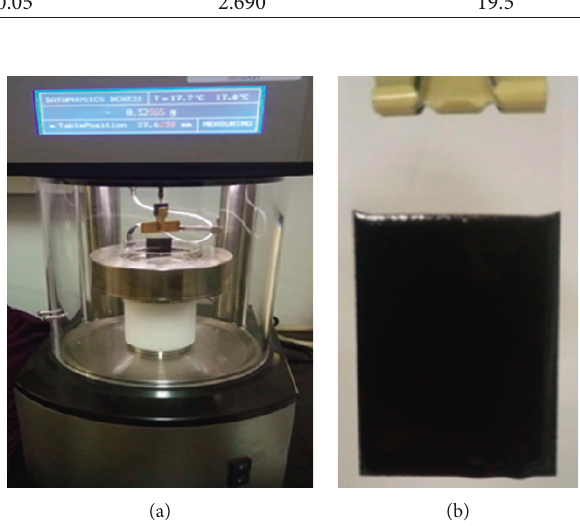
Figure 1: Surface tension meter and sample to be